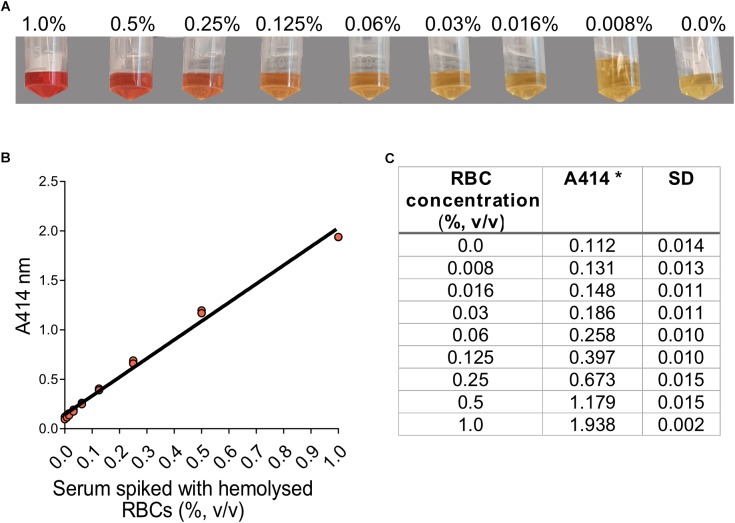
Visual inspection and absorbance measurement of hemolyzed red blood cells in serum. (A) Serum with low initial absorbance at 414 nm was spiked with varying amounts of hemolyzed RBCs. The percentage indicated is v/v. (B) Absorbance at 414 nm for the different concentrations of hemolyzed RBCs in serum. The three replicates for each concentration are plotted. (C) A414 at different RBC-concentrations (%, v/v) in serum.